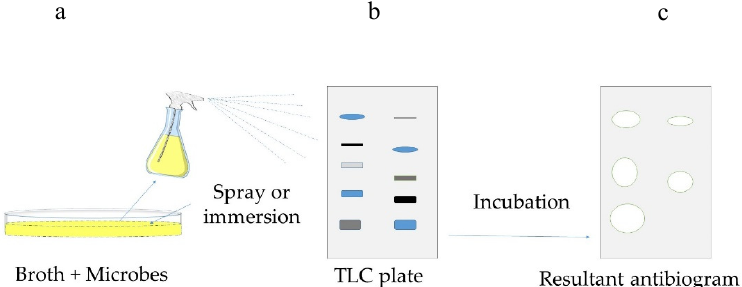
Figure 9. Schematic presentation of direct bioautographic method: ( a ) a developed chromatographic plate is placed in a dish; ( b ) agar is poured into this dish, and later, microbes are inoculated and ( c ) after the incubation time, the zones of inhibition can be seen on agar around the active antimicrobial compounds (the figure is adapted from [14,128–130]).